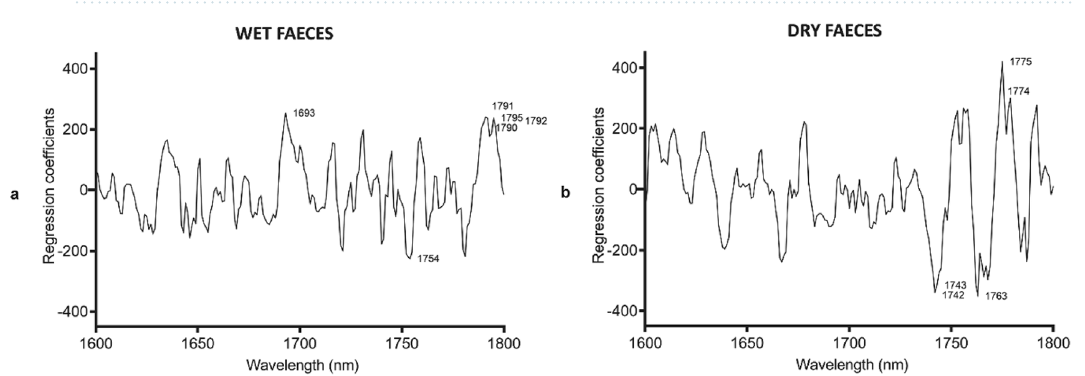
Figure 3. Average NIR spectra in the 350–2500 nm region from T. infestans excreta. ( a ) Average NIR spectra in wet faeces (orange for uninfected and green for T. cruzi- infected group). ( b ) Average NIR spectra in dry faeces (brown for uninfected and blue for T. cruzi- infected group).